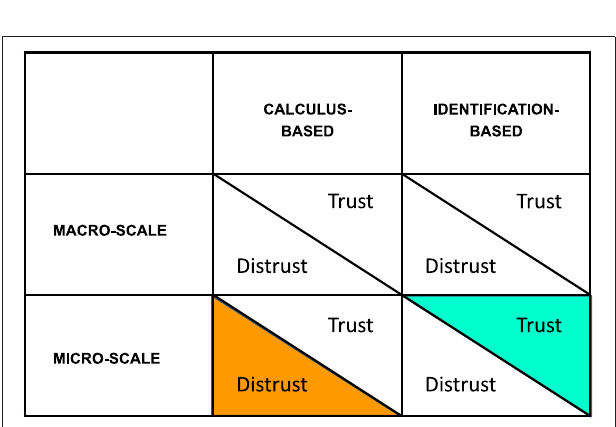
FIGURE 5 | “Toyota makes a really good car, but our local dealership is really